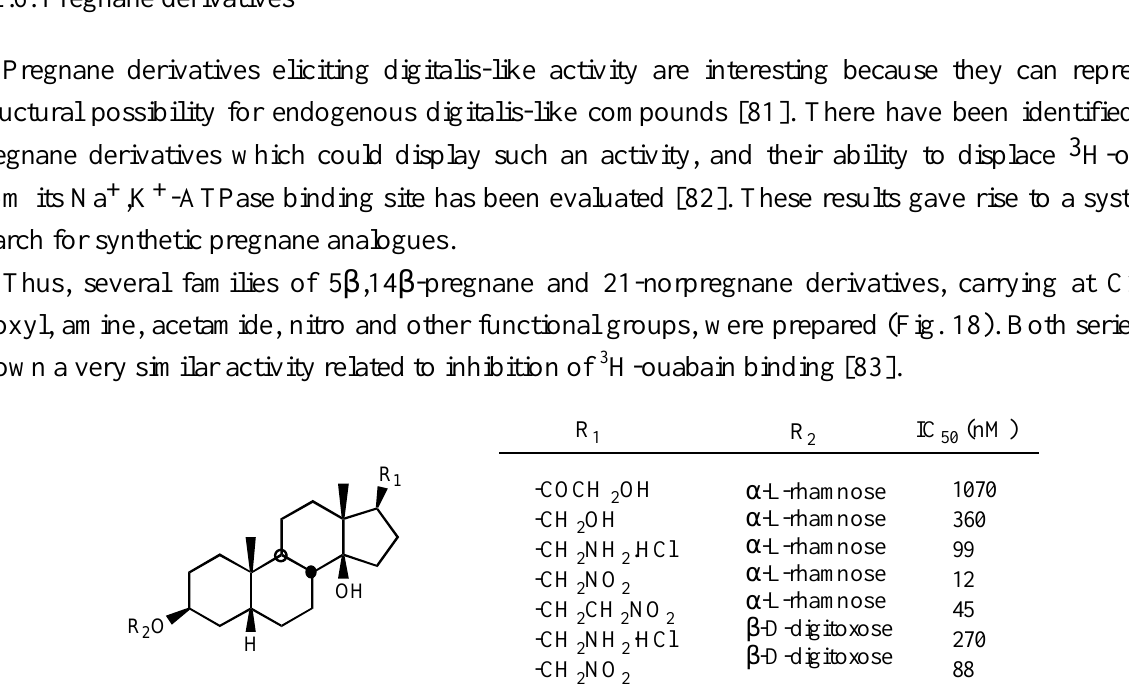
Figure 18. Structure of some pregnane and 21-norpregnane derivatives. IC inhibiting 50% of 3 H-ouabain